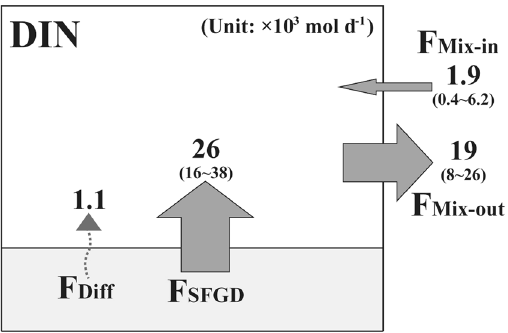
Figure 3. The DIN budget showing the DIN fluxes ( × 10 3 mol d − 1 ) though fresh groundwater